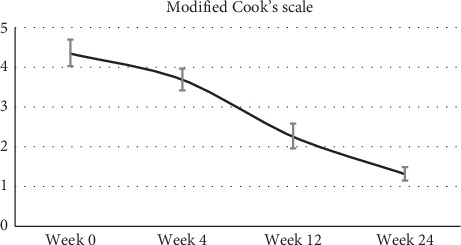
Global acne assessment using modified Cook's scale: The data represent the modified Cook's scale analysis made during each visit (at week 9, week 4, week 12, and week 24). The error bars are average ± SEM.